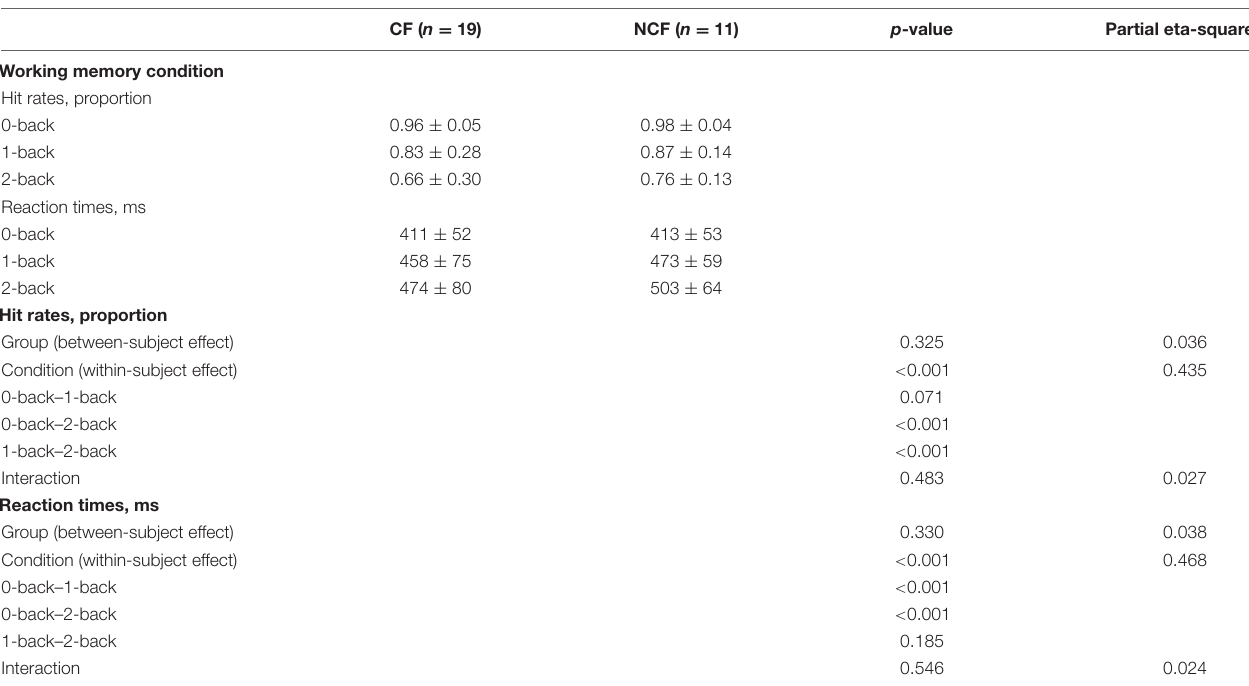
TABLE 4 | Behavioural data n-back